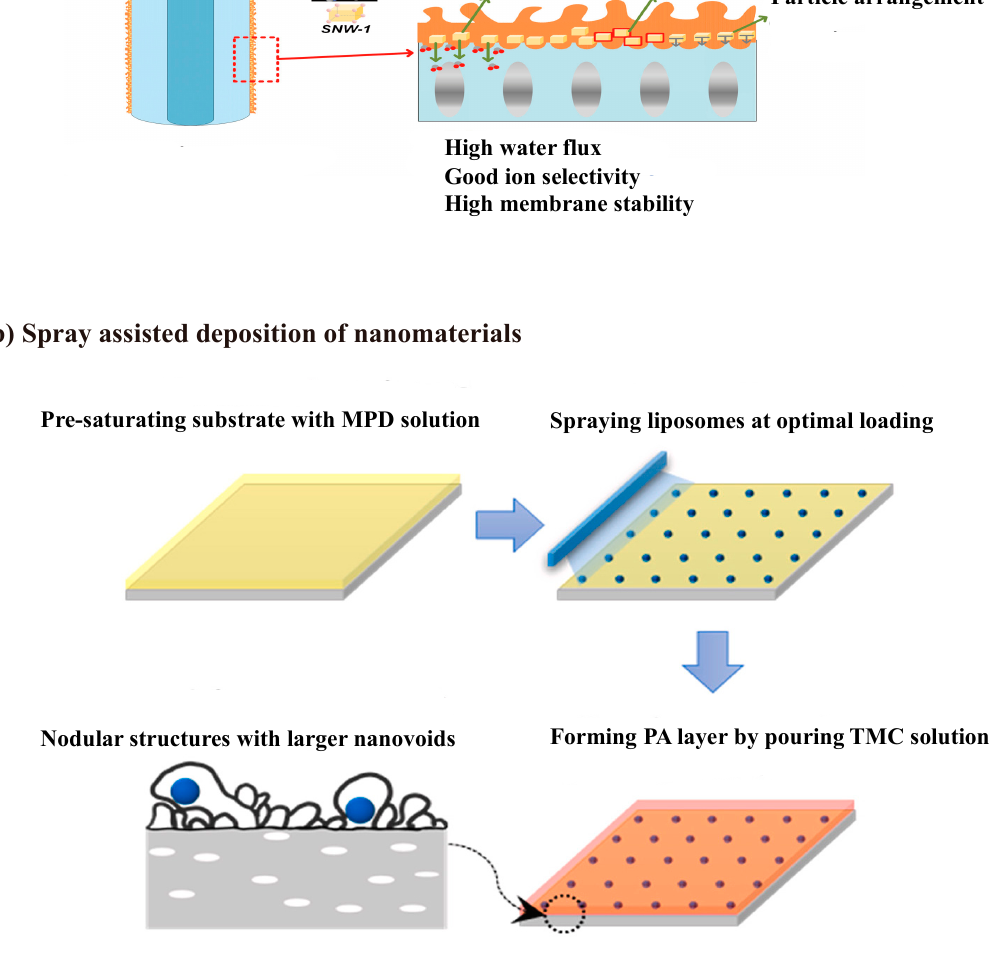
Figure 9. Methods for incorporating nanomaterials in the selective layer. Vacuum-assisted deposition of nanoparticles ( a ) and spray-assisted disposition of liposomes ( b ) into polyamide layer via interfacial polymerization approach. All the figures were taken from the references.